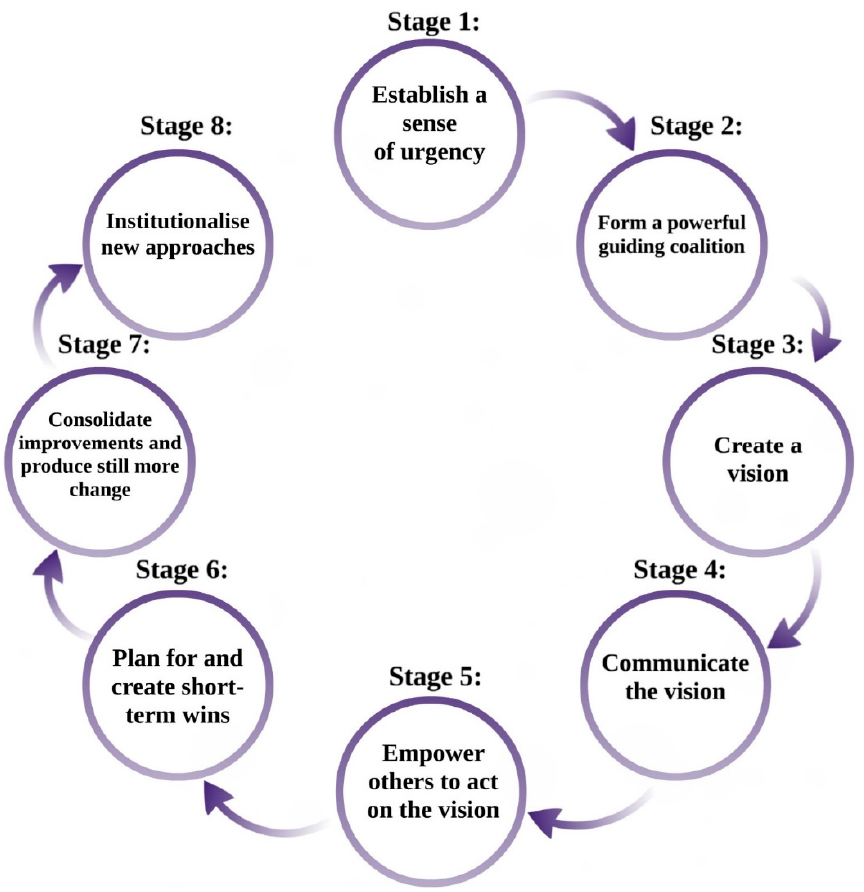
Figure 1. Adapted from Kotter’s (1996) Change Stages.